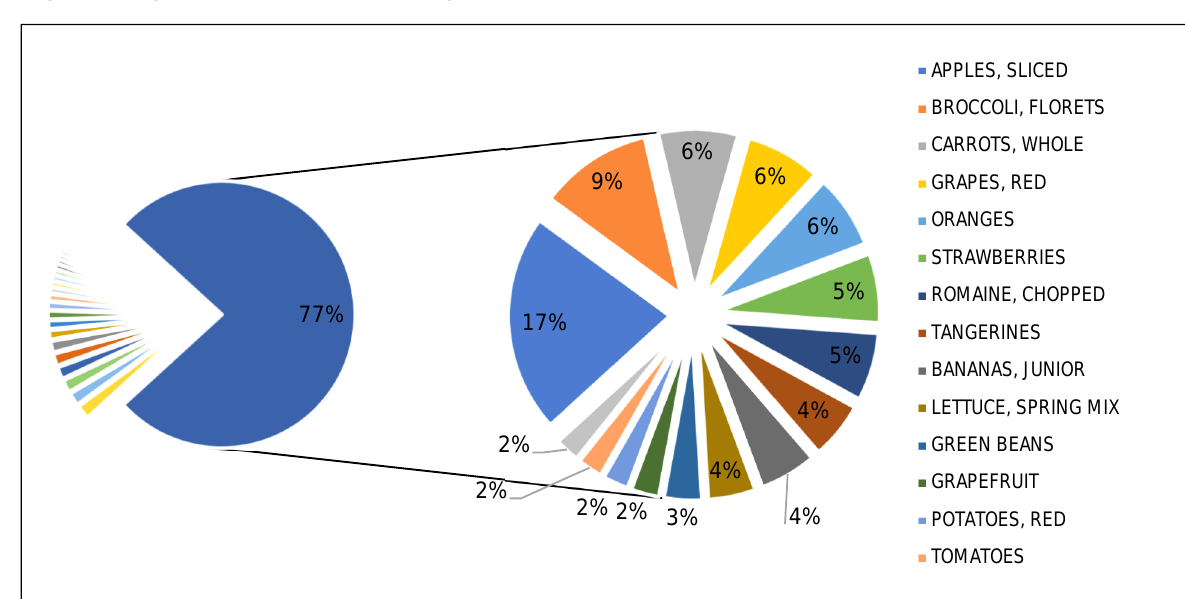
Figure 1. Top 15 Products as Percentage of Total Annual